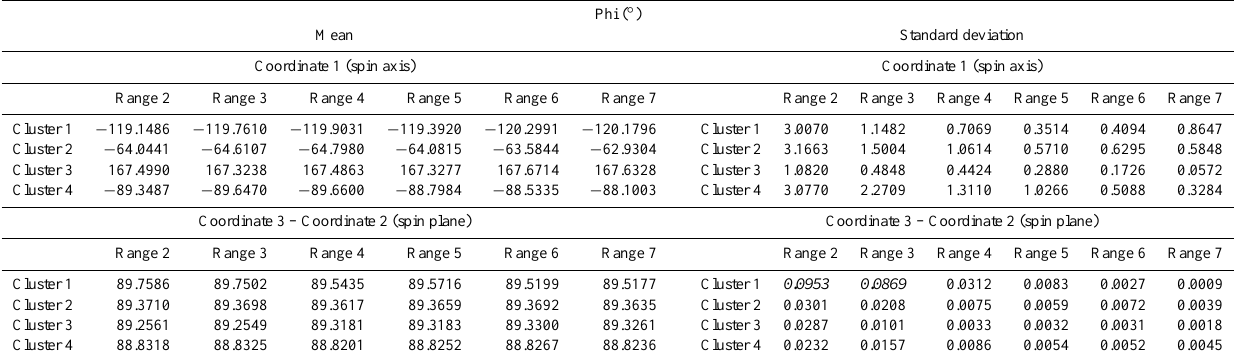
Table 5. Mean and standard deviation of azimuthal angles ( ϕ 1 and 1ϕ 32 ) for the segment from February 2001 to February 2012 in every range on all spacecraft. Standard deviations for ranges that are at least twice as large as those for all the other spacecraft in that range are highlighted in